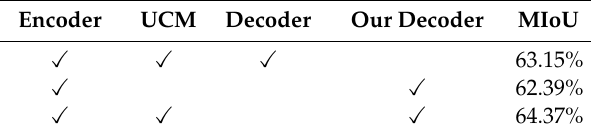
Table 5. MIoU values in di ff erent situations.